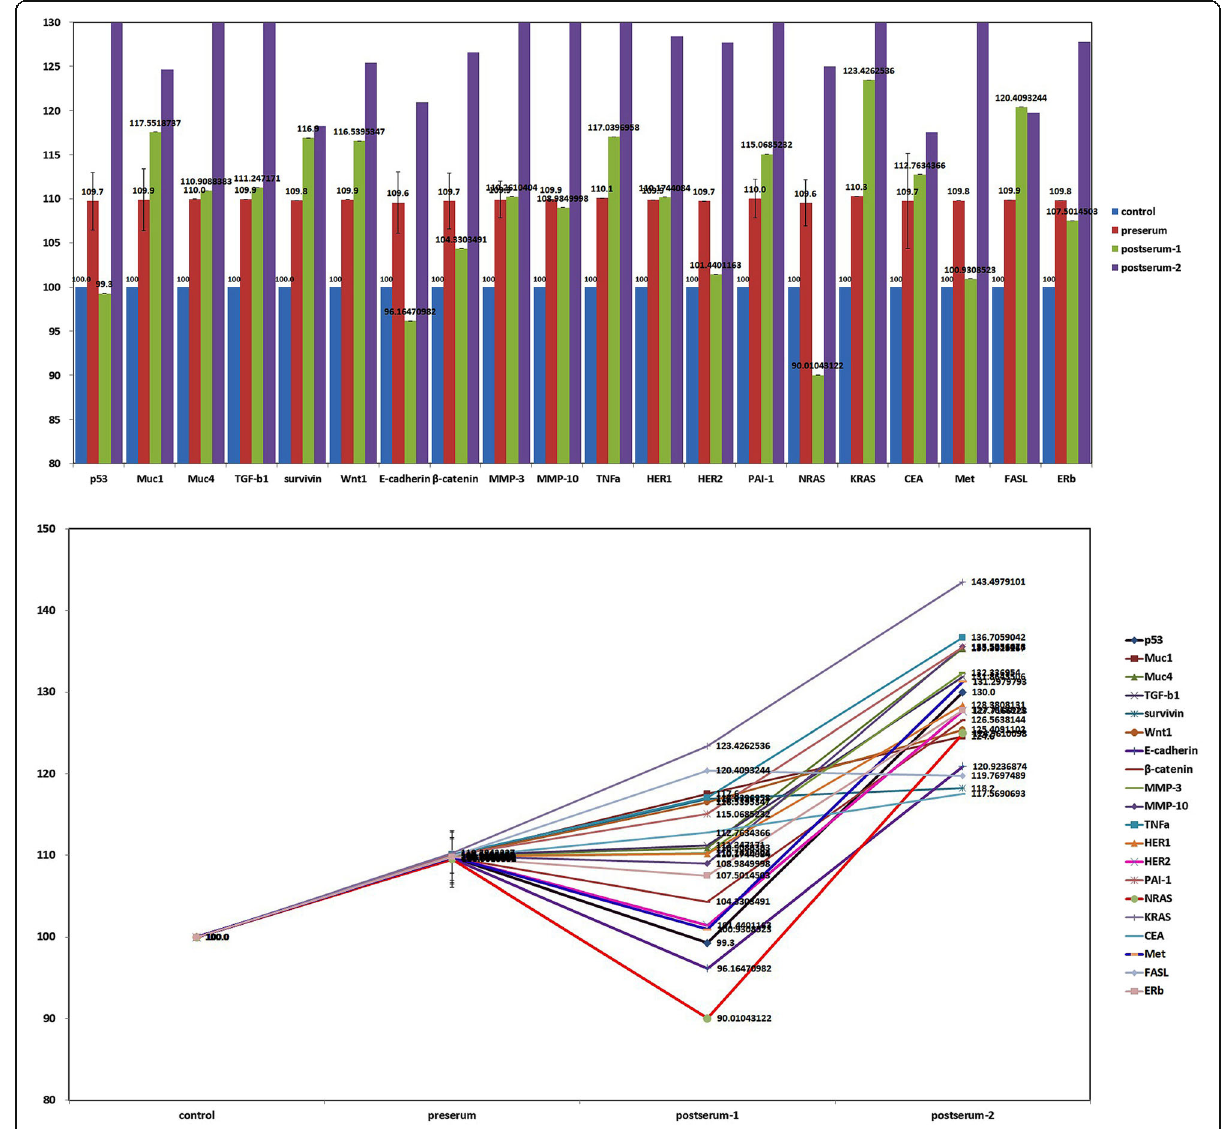
Fig. 4 An upper bar graph and a lower line graph comparing oncogenic protein expression profiles between preoperative, postoperative 10 days, and postoperative 3 months after first ablation